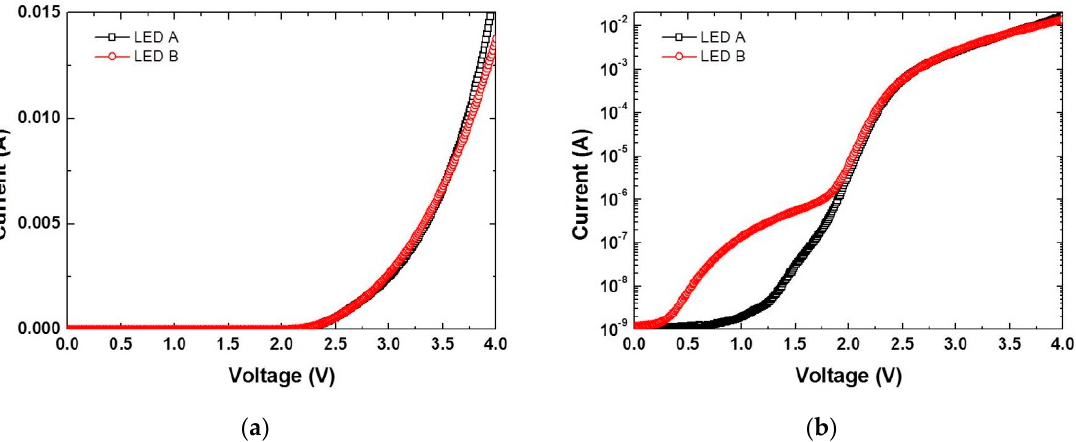
Figure 3. Current-voltage characteristics (I–V curve) for LED A and LED B ( a ) linear scale and ( b ) in semi-log scale.